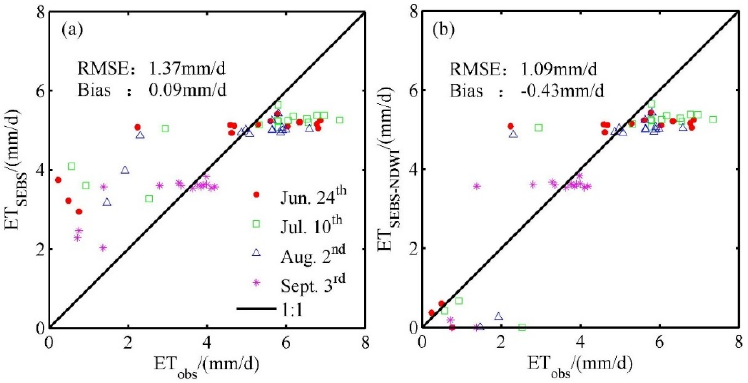
Figure 9. Comparison of modeled and observed daily evapotranspiration at 16 stations on 24 June, 10 July, 2 August, and 3 September, 2012. ( a ) and ( b ) are scatter plots of the daily observations of evapotranspiration and the results from the original SEBS and NDWI-integrated SEBS.